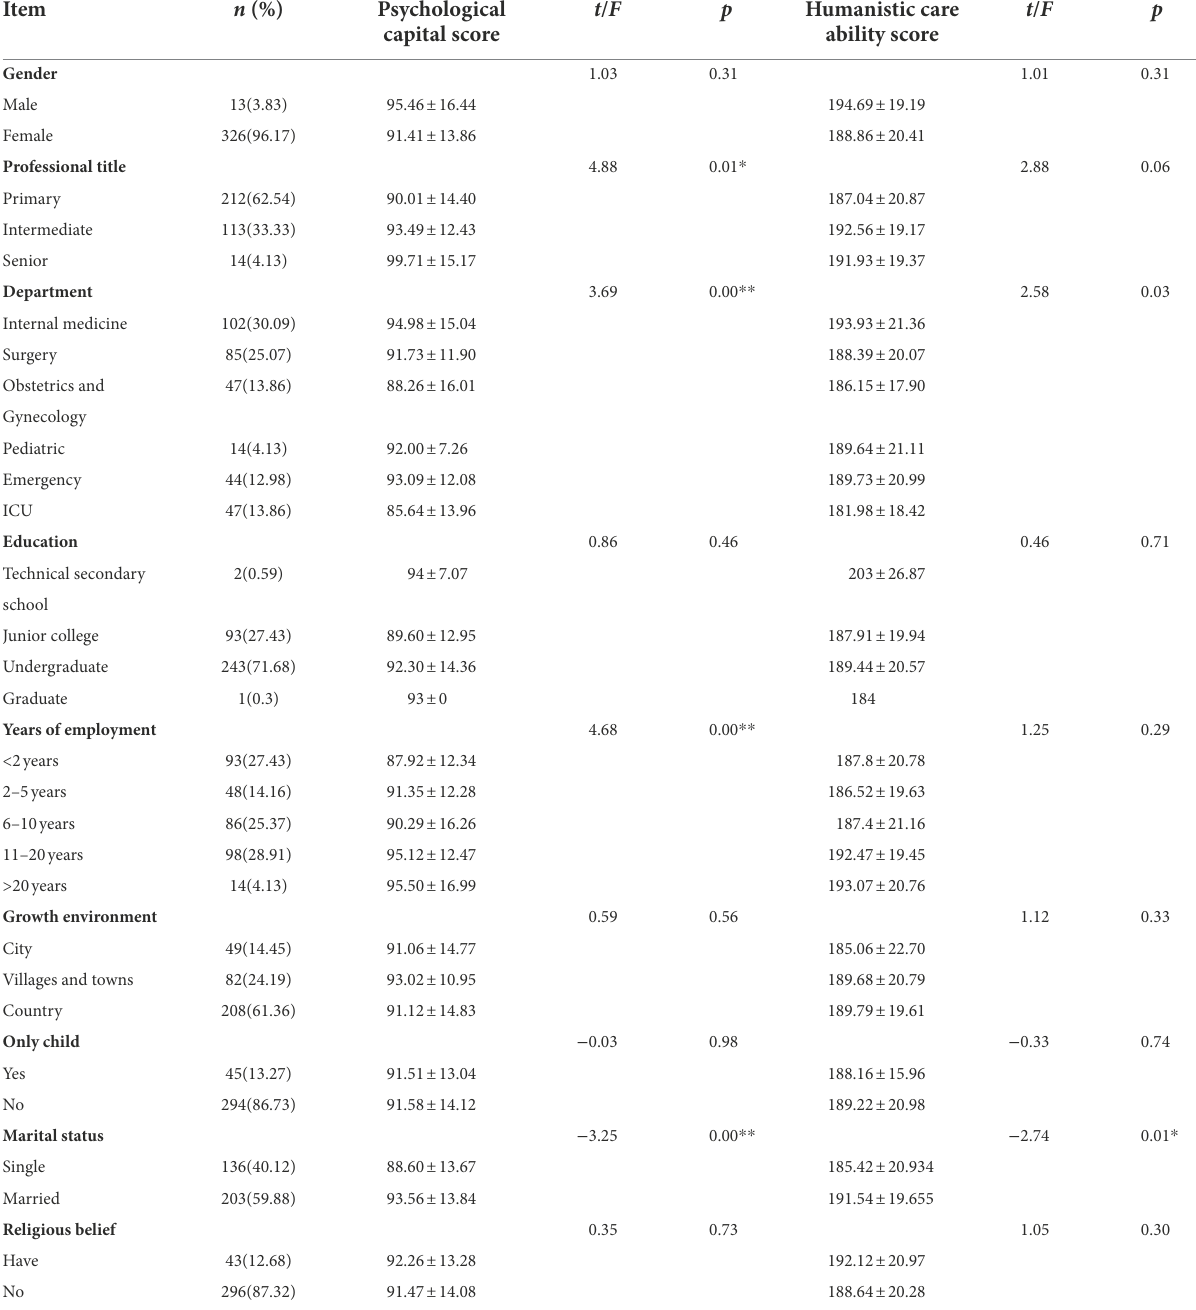
TABLE 2 Comparison of the psychological capital score and humanistic care ability among nurses with different